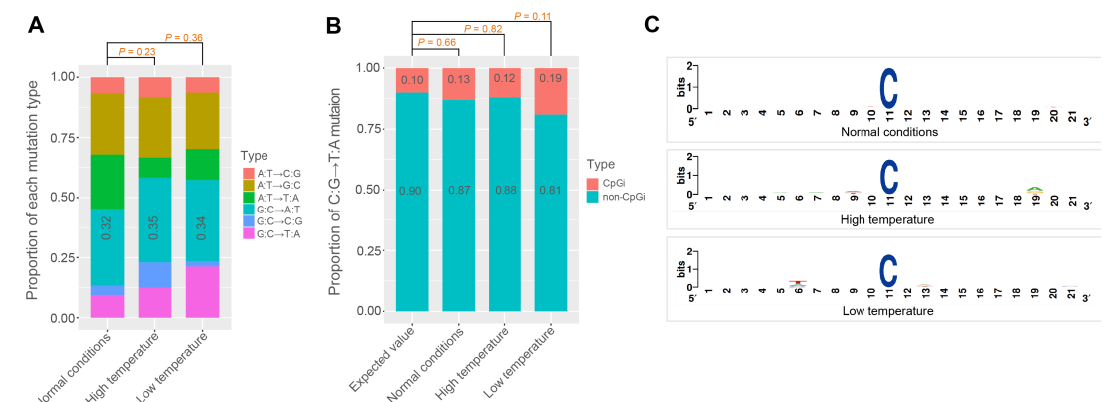
Figure 3. The G:C → A:T mutation bias. ( A ) The proportions of six mutation types in the silkworm under different conditions (chi-square test). ( B ) The proportions of C:G → T:A mutation sites in CpG island and non-CpG island regions. The expected value was obtained assuming the mutation follows random distribution. The total length of the CpGi region accounts for about 10% of the whole genome sequence. A two-sample test of proportions (prop.test function of R package) was used to test the significance of the difference of the distributions between observed and expected values. ( C ) The logos of flank sequences (10 bp of each side) of the C:G → T:A mutation sites in the reference genome. Table 2. The mutation rate of different mutation types of silkworms under different conditions. The 95% confidence interval of the mutation rate was estimated using the bootstrap method with 1000 bootstrap estimates. The G:C → A:T mutation rate was highest in each treatment and is repre- sented in bold type.